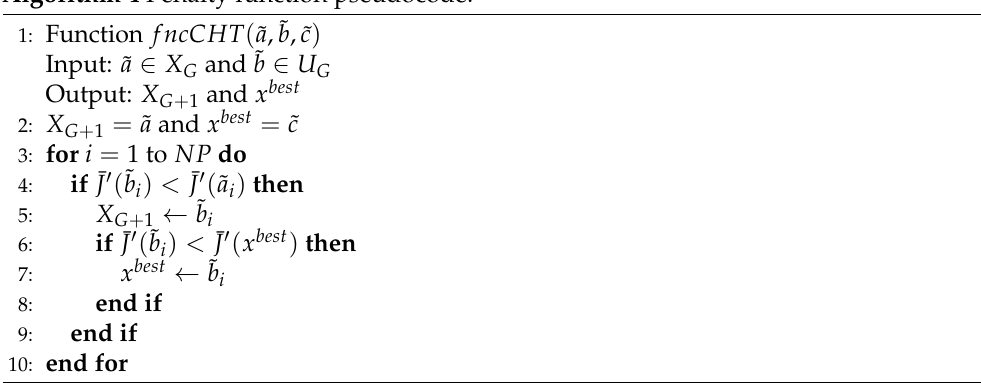
Algorithm 4 Penalty function